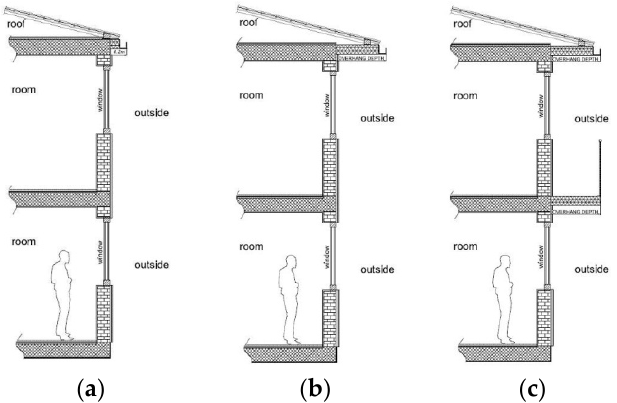
Figure 2. Overhang geometry: ( a ) basic building, ( b ) ORO building and ( c ) OBO building.